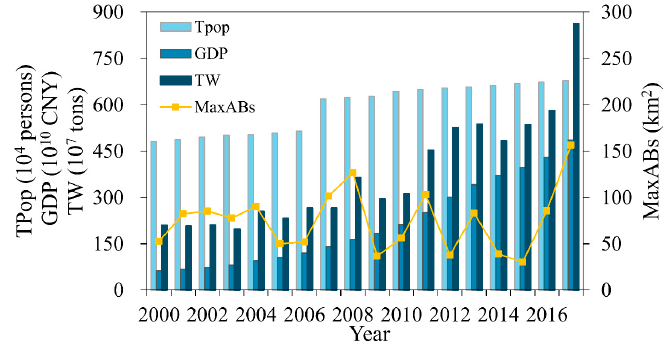
Figure 20. Total population, GDP, and total wastewater discharge in Kunming during 2000–2017.